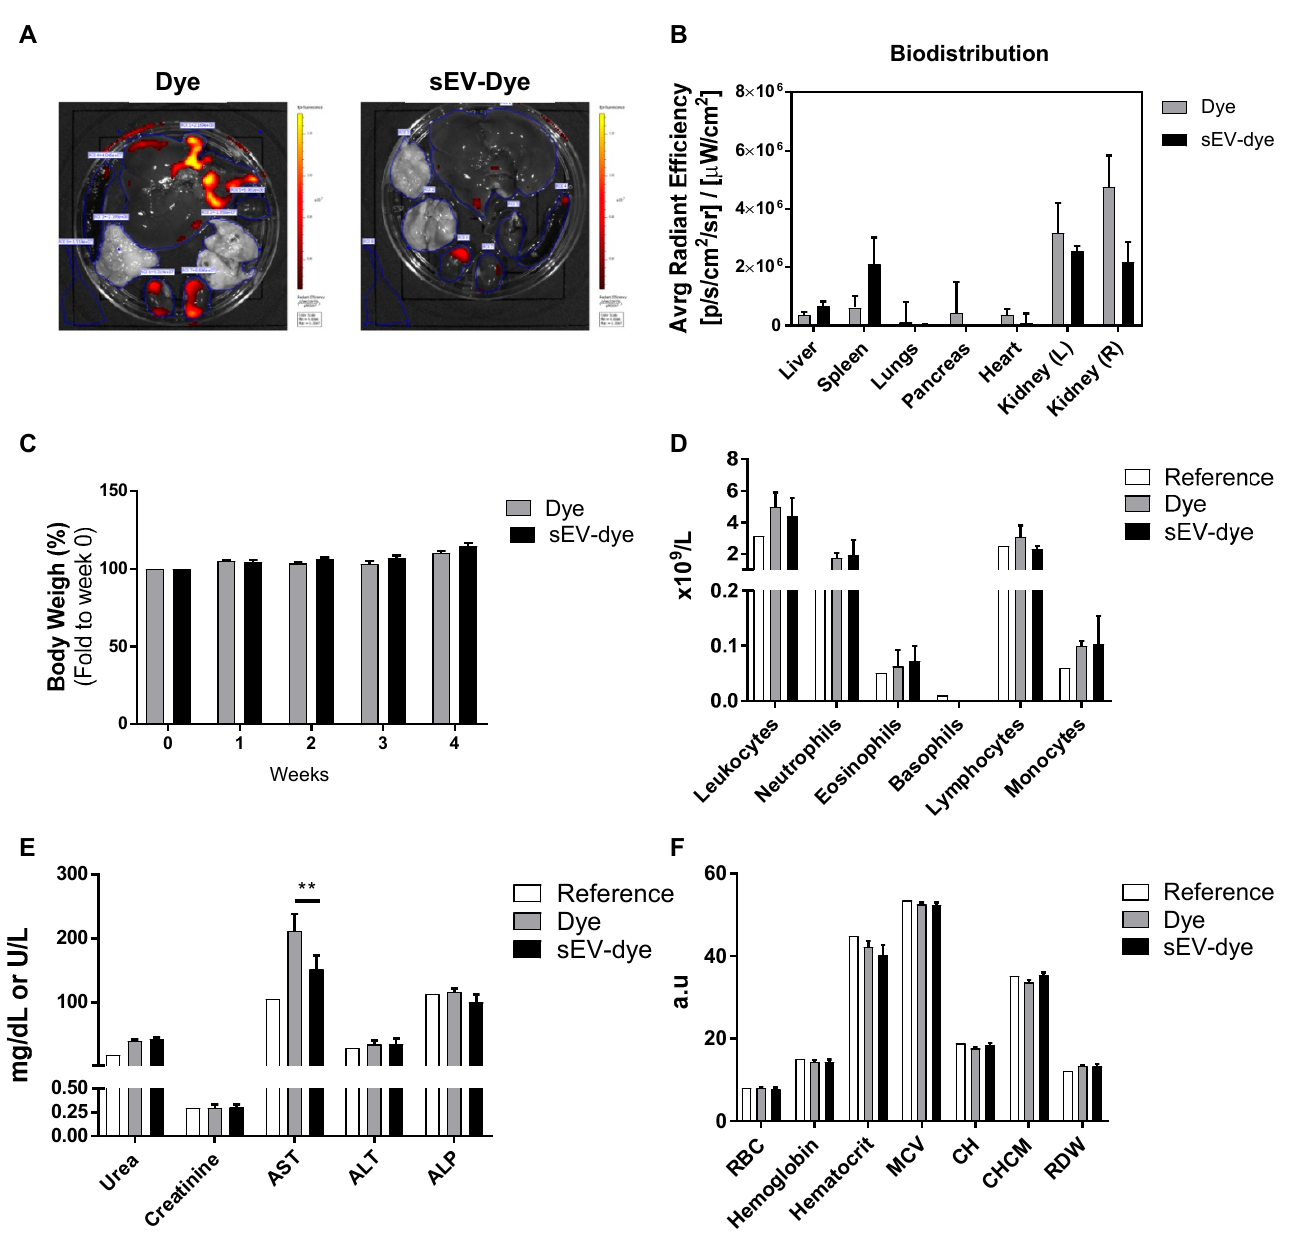
Figure 2. Biodistribution and toxicological profile of UCB-MNC-sEV in rats. Wistar Han rats were injected intravenously with fluorescently labelled UCB-MNC-sEV in PBS, twice a week for 4 weeks. After sacrifice, organs were analysed for accumulated fluorescence (IVIS) and blood was collected to evaluate signs of systemic toxicity. Control (Dye) animals were injected with the same dye concentration as used for labelled UCB-MNC-sEV. ( A ) Representative images of organs’ fluorescence. ( B ) Biodistribution of sEV-dye and dye alone. ( C ) Graphic representation of weight evolution during the 4-week experiment. Graphic representation of ( D ) leukogram, ( E ) biochemical, and ( F ) hemogram results acquired at the end of the experiment. Reference values were obtained from Charles River. Results are presented as mean ± SEM. Statistical analysis was performed by ANOVA ( n = 4 rats per condition). If not otherwise marked, no statistically significant difference was found between dye and sEV-dye. RBC: red blood cell count; MCV: mean corpuscular volume (MCV); CH: cell haemoglobin; CHCM: mean cell haemoglobin concentration; RDW: RBC distribution width; a.u.: arbitrary units. ** p value <